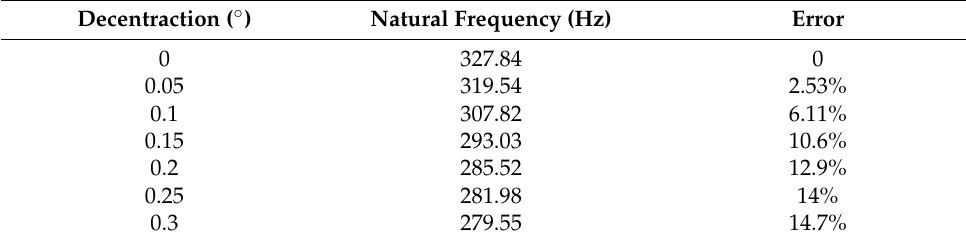
Table 7. The change rate of the natural frequency of the 5th order.